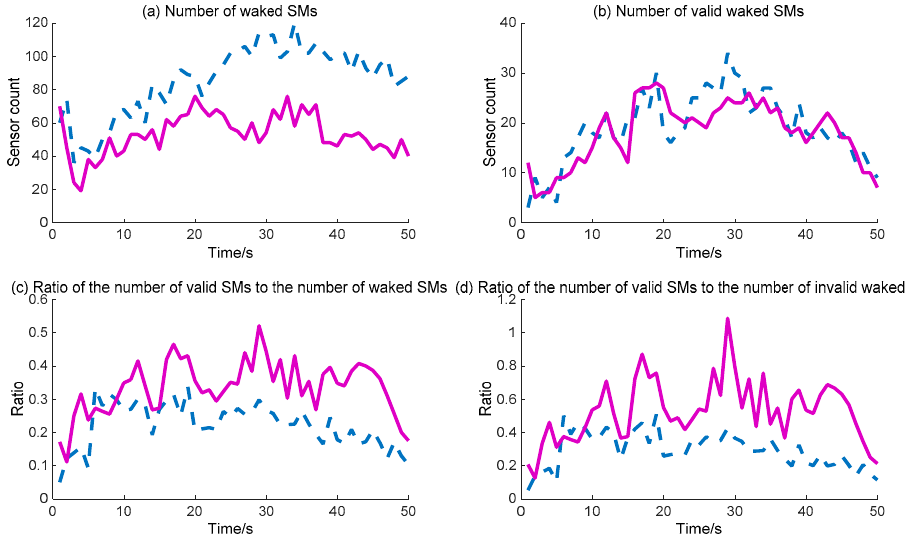
Figure 11. The WC performance of SMs: ( a ) Number of waked SMs. ( b ) Number of valid waked SMs. ( c ) Ratio of the number of valid SMs to the number of waked SMs. ( d ) Ratio of the number of valid SMs to the number of invalid waked SMs. ( — : BDIIM; –: distributed infectious disease model (DIDM)). Table 5. Data of the SM performance of nodes in WC.